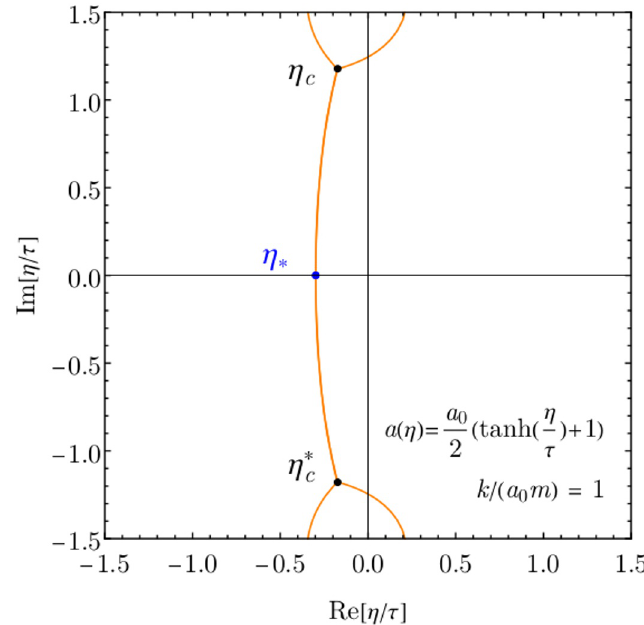
Figure 4 . An illustration of the complex- η plane showing turning points η c and η ∗ crossing point η ∗ (blue dot) and Stokes lines (orange curves) close to the real axis. Additional turning points are found at larger values of | Im[ η/τ ] | . The early Stokes region containing η → −∞ and the late Stokes region containing η → + ∞ share a common border at the central Stokes line shown here. The real axis intersects this Stokes line at the blue